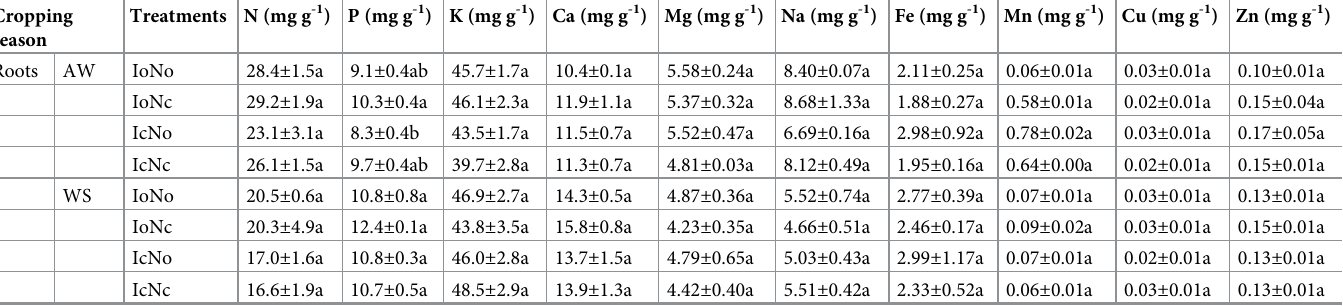
Table 6. Concentration of macro- and micro-elements in roots and shoots under different treatments in autumn-winter (AW) and winter-spring (WS) cropping seasons. Treatments codes are the same as in Table 1. Cropping